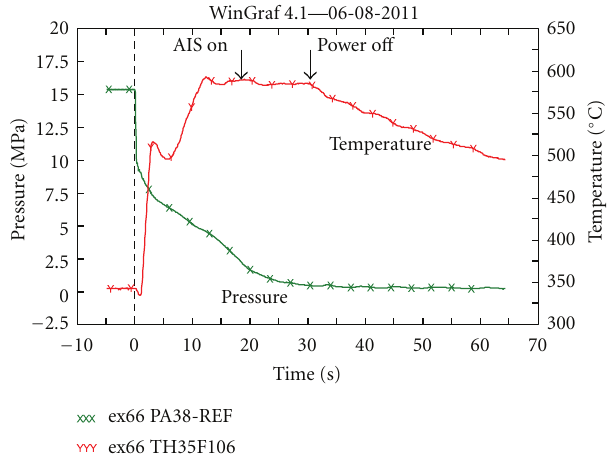
Figure 4: Primary system pressure and heater rod temperature res- ponse to a large 200% cold leg break LOCA (downcomer gap width